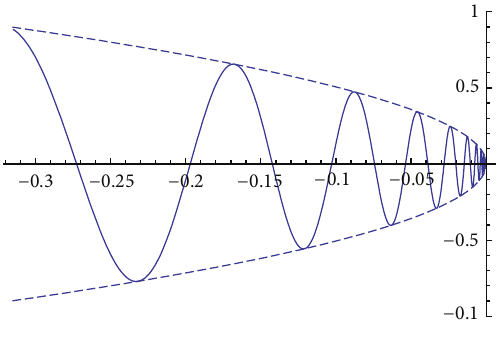
Figure 2: 𝑦 is oscillatory near 𝑥 = 0 from the left